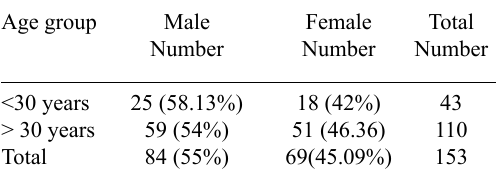
Table 2. Age and sex wise distribution of scrub typhus Age group